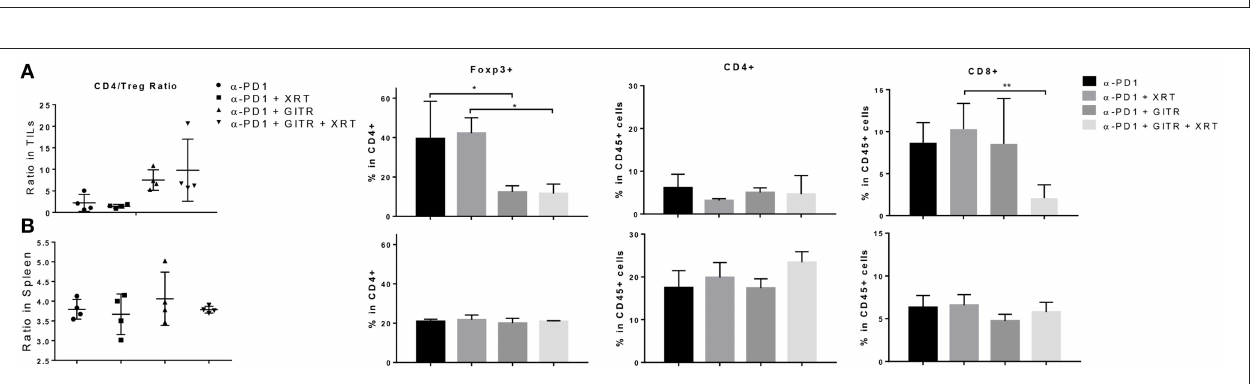
FIGURE 3 | Regulatory T cells express the highest levels of GITR, especially at the tumor site, and are increased by radiation. 2 and 6 days post XRT, immune cells were isolated and phenotyped through flow cytometric analysis from either unirradiated or irradiated mice. CD45 + cells were further gated into either CD4 + , CD8 + or Foxp3 + within CD4 + ( n = 4 per group). (A) These values are represented graphically. (B) Representative MFI (mean fluorescence intensity) of GITR expression in control mice, 48h and 6 days post XRT in CD8 + , CD4 + Foxp3–, CD4 + Foxp3 + , and myeloid ( Supplementary Figure 1 ) cells with unstained and FMO controls ( n = 16). (C) Averages of mean fluorescence intensity (MFI) of CD4 + Foxp3 + , CD4 + Foxp3–, CD8 + , and myeloid cells from all treatment groups ( n = 18). * P ≤ 0.05; ** P ≤ 0.01; *** P ≤ 0.001; **** P ≤ 0.0001 in Student t -tests; N.S., not statistically significant.